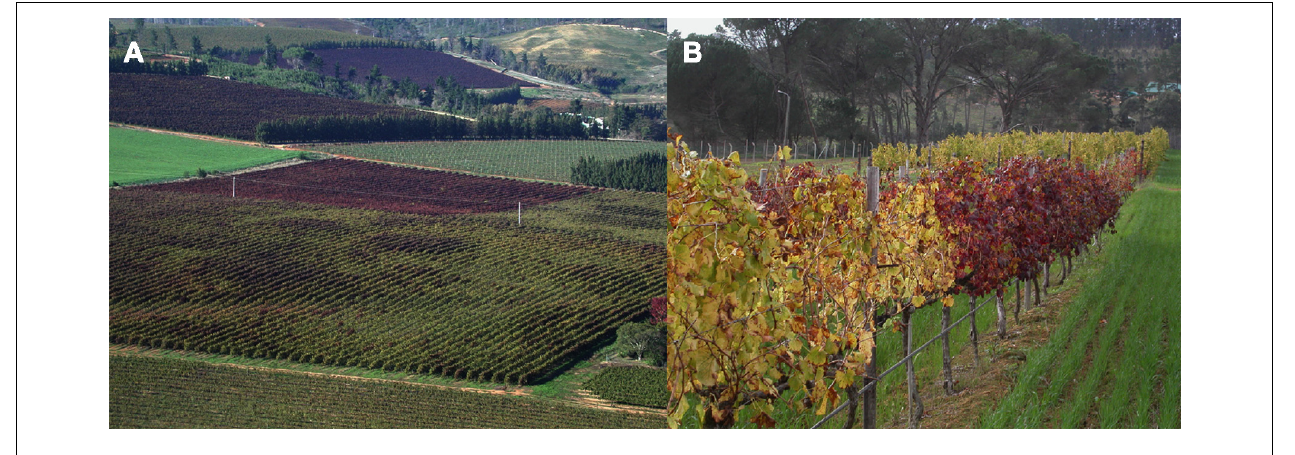
within-block spread. (B) Example of secondary spread within rows, where an initial infection spread to neighboring plants. Both photographs were taken from the wine-producing region ofWestern Cape, South